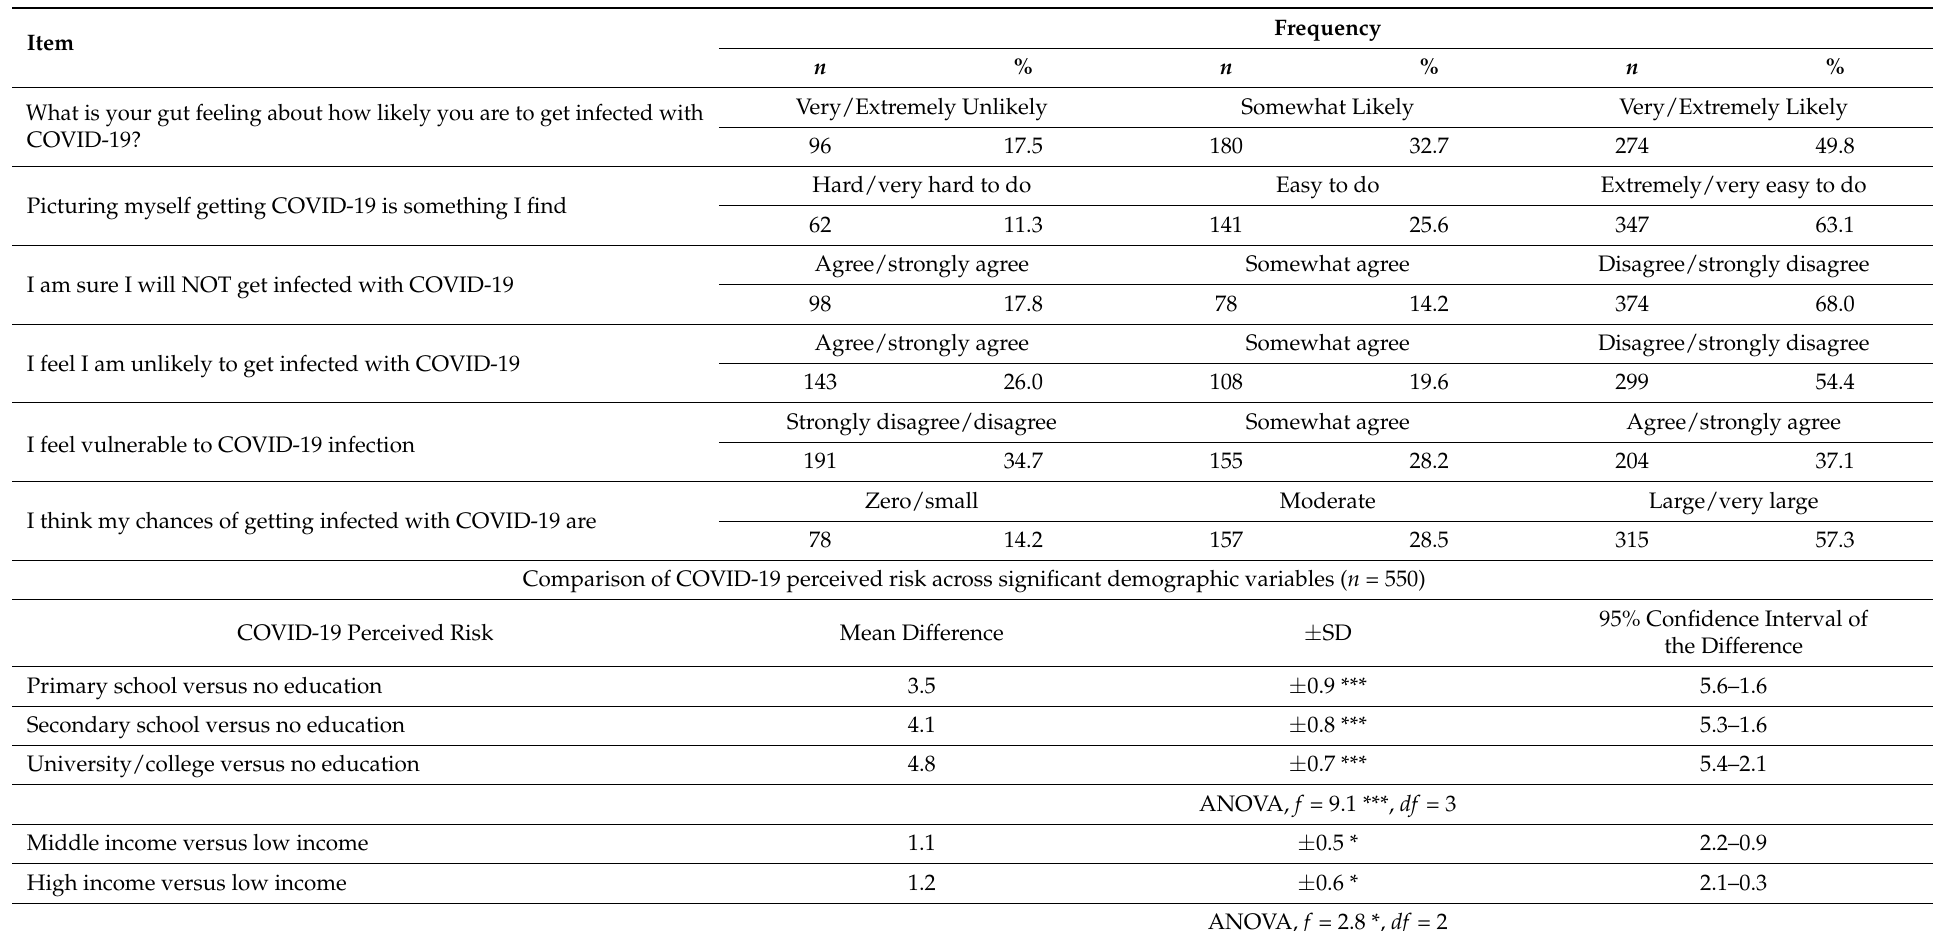
Table 2. Perceived risk of COVID-19 ( n =